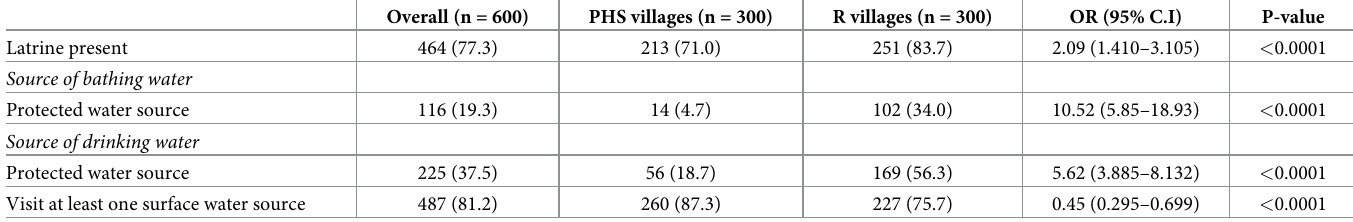
Table 5. Univariate logistic regression on the nature of water, sanitation and hygiene in study villages from household